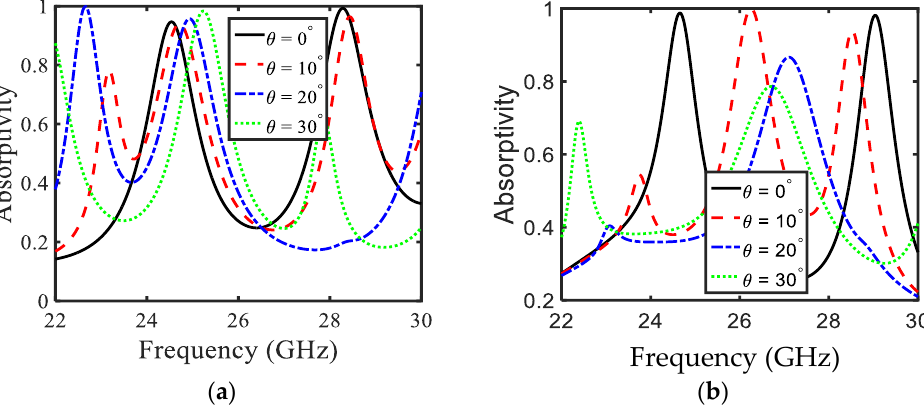
Figure 4. Absorption of the proposed PA keeping substrate thickness t = 1.6 mm for ( a ) TE polarization ( b ) TM polarization.